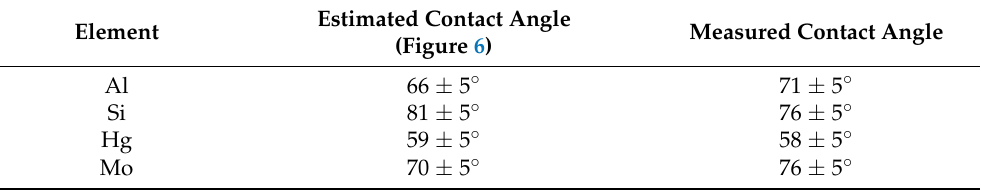
Table 2. Comparison of the estimated and measured contact angle of water on Al, Si and Mo surfaces. Element